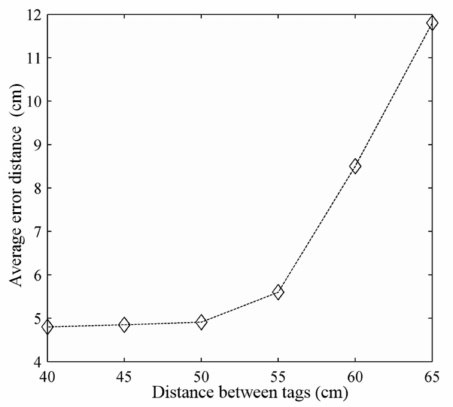
Figure 14. Effects of tag interval on the average positioning error.